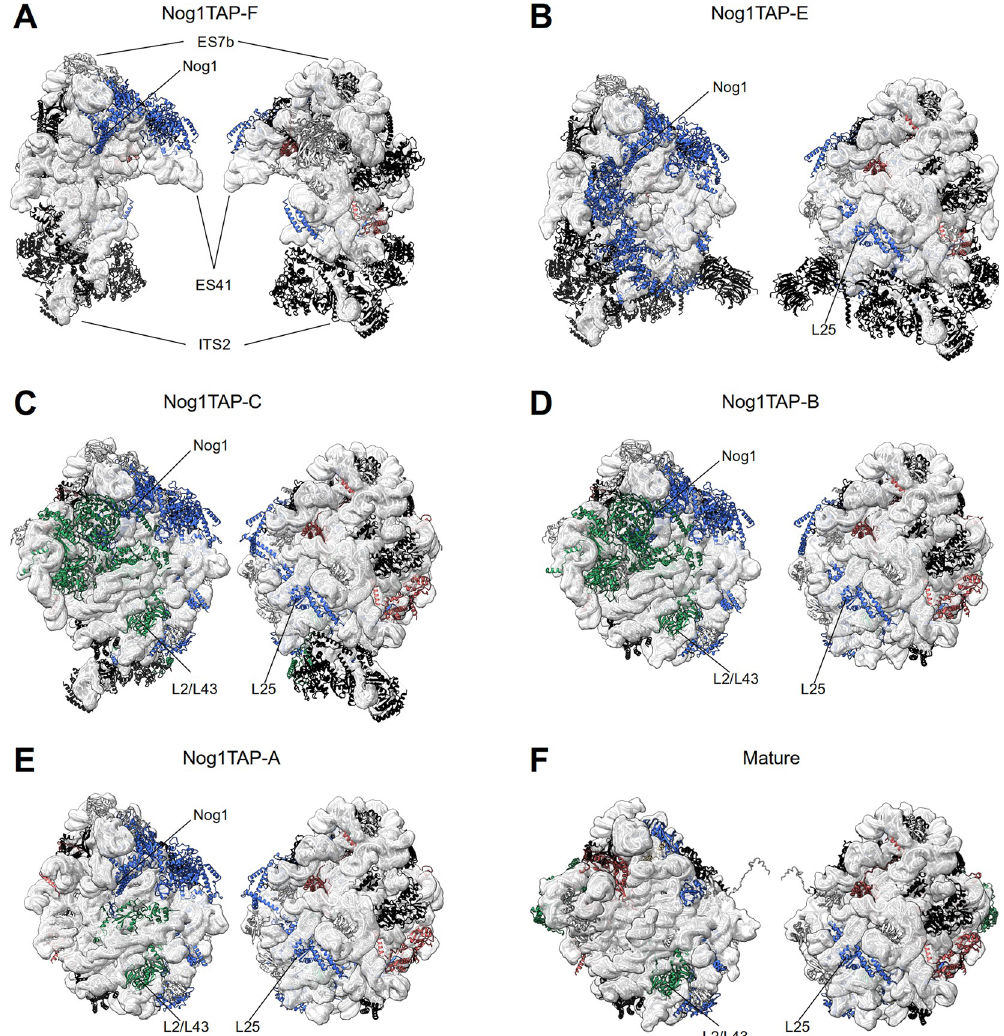
Fig 2. Structure models of Nog1-TAP associated particle populations from yeast cells with endogenous r-protein expression levels (Y1877). rRNA of the respective structure models is shown in white cartoon backbone representation and is further highlighted by a transparent model-volume representation (8 Å resolution), proteins are shown in cartoon backbone representation with colouring according to functional categories: Proteins required for early pre-rRNA processing are shown in black, for intermediate nuclear pre-rRNA processing steps in blue, for late nuclear pre-rRNA processing steps in green and for downstream nuclear maturation and export in red. Non-essential proteins and proteins with unclear function are shown in grey (see also S6 Appendix). The LSU subunit interface side is shown on the left and the subunit solvent surface side on the right for Nog1TAP-F in (A), for Nog1TAP-E in (B), for Nog1TAP-C in (C), for Nog1TAP-B in (D) and for Nog1TAP-A in (E). Mature large ribosomal subunits are represented in (F). Positions of RNA helices ES7b, ES41 and the ITS2 are indicated in (A) for orientation purposes as well as the positions of Nog1, the rpL2/rpL43 heterodimer and rpL25 if present in the respective model. Detailed protein compositions and model-based protein-protein and protein-RNA interaction-networks are schematically represented in figures A—G in S1 Appendix.